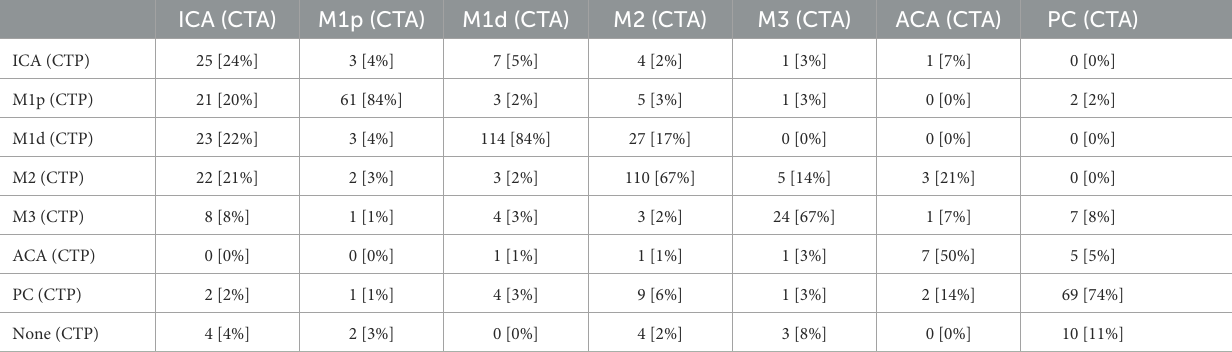
TABLE 4 The confusion matrix for the annotated vessel occlusion locations from CT angiography (CTA) and the indicated vessel occlusion locations from CT perfusion (CTP) if we allow the second-best indication to also count as correct.